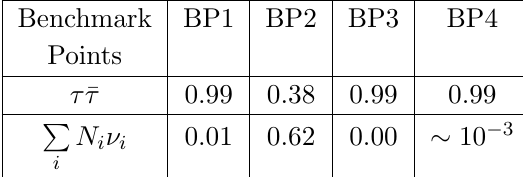
= 0 : 5 ; Y N = 1 2 ; 3 N i . i